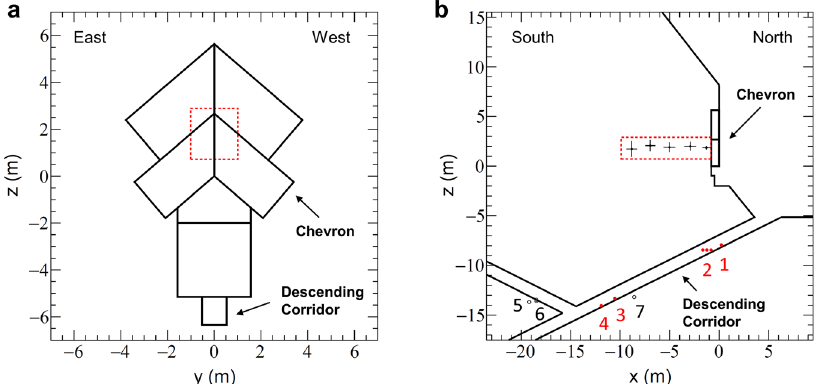
Fig. 5 | Results of the analysis of the nuclear emulsion fi lms by Nagoya Uni- versity. ThelocationandshapeoftheNFCareshownincross-sectionalviewsofthe analysisarea including Chevron from the North ( a ) and East ( b ) sides. Locations of EM1toEM4detectorsinstalledintheDCandobtainedresultsareshowninred,and EM5toEM7installedintheMCareshowninblack,respectivelyin b .Thereddotted